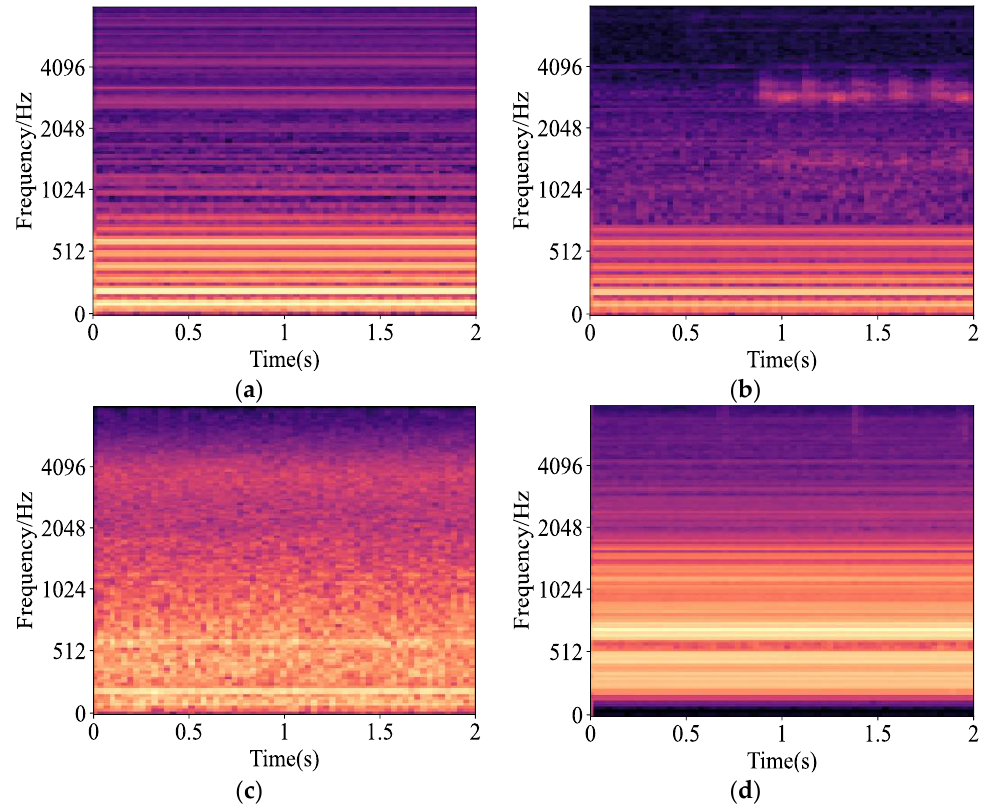
Figure 3. Mel time spectrum of a typical fault: ( a ) Normal; ( b ) Short - circuit impulse; ( c ) Partial discharge; ( d ) DC bias.